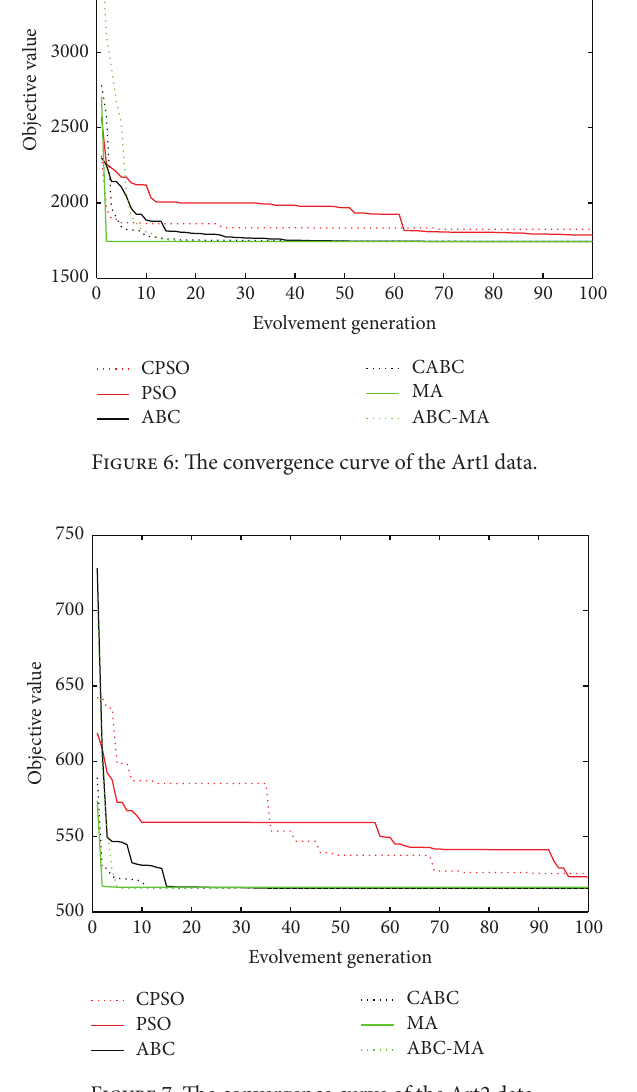
patterns were drawn from four independent bivariate normal distributions, where classes were distributed according to (𝑚 0.5 0.05 𝑖 (𝜇 = ) , Σ = [ 𝑁 ]) , (8) 2 0 0.05 0.5 = −3 , 𝑚 = 0 , 𝑚 = 3 , 𝑚 = 6 , 𝜇 and Σ being 𝑖 = 1, 2, 3, 4 , 𝑚 1 2 3 4 mean vector and covariance matrix, respectively [12, 14]. The data set is illustrated in Figure 5.